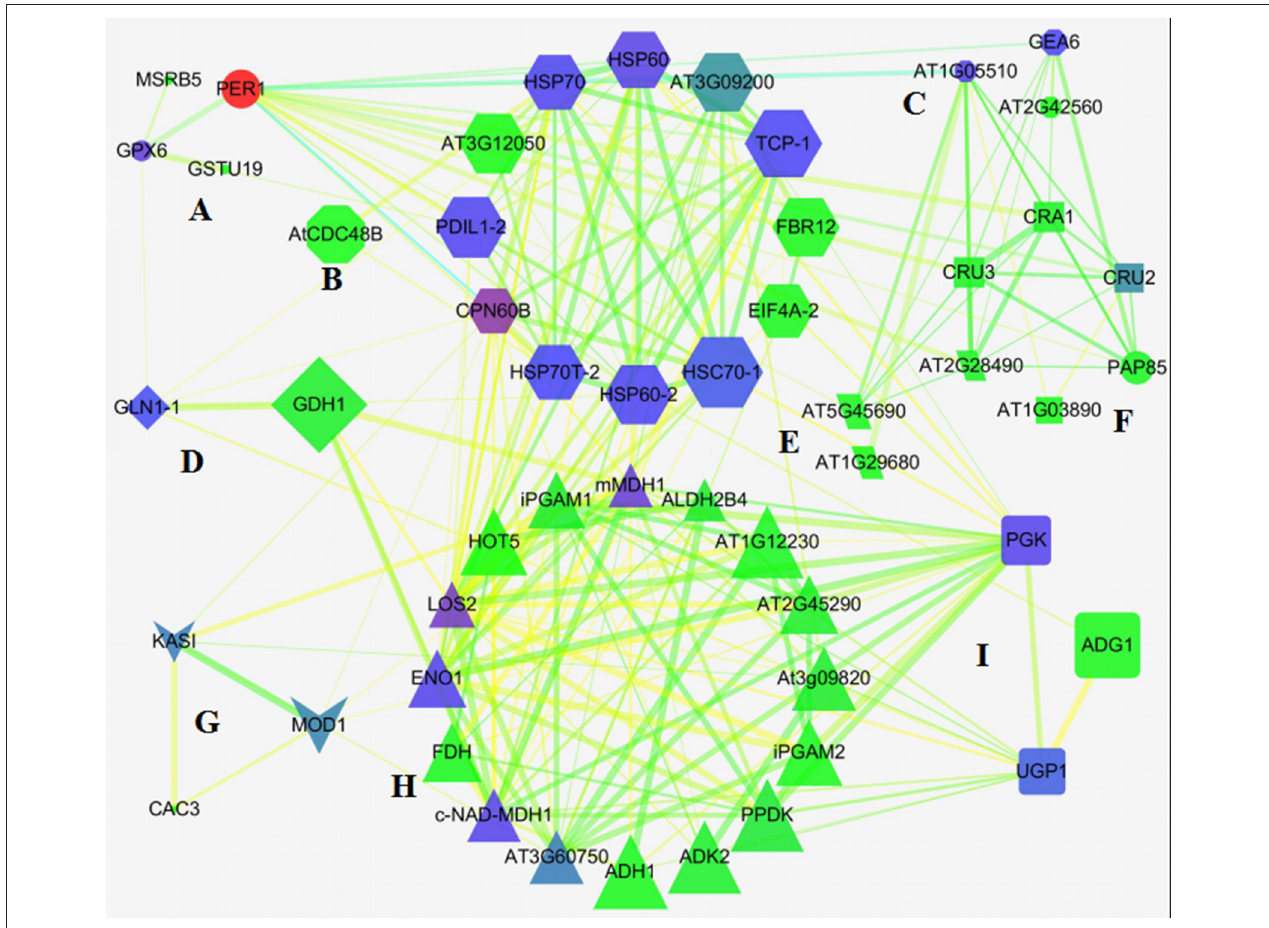
FIGURE 5 | Network of DEPs in germinating seeds. (A) Defense/disease; (B) unknown; (C) seed maturation; (D) amino acids metabolism; (E) protein metabolism; (F) storage proteins; (G) lipid metabolism; (H) energy metabolism; (I) carbohydrate